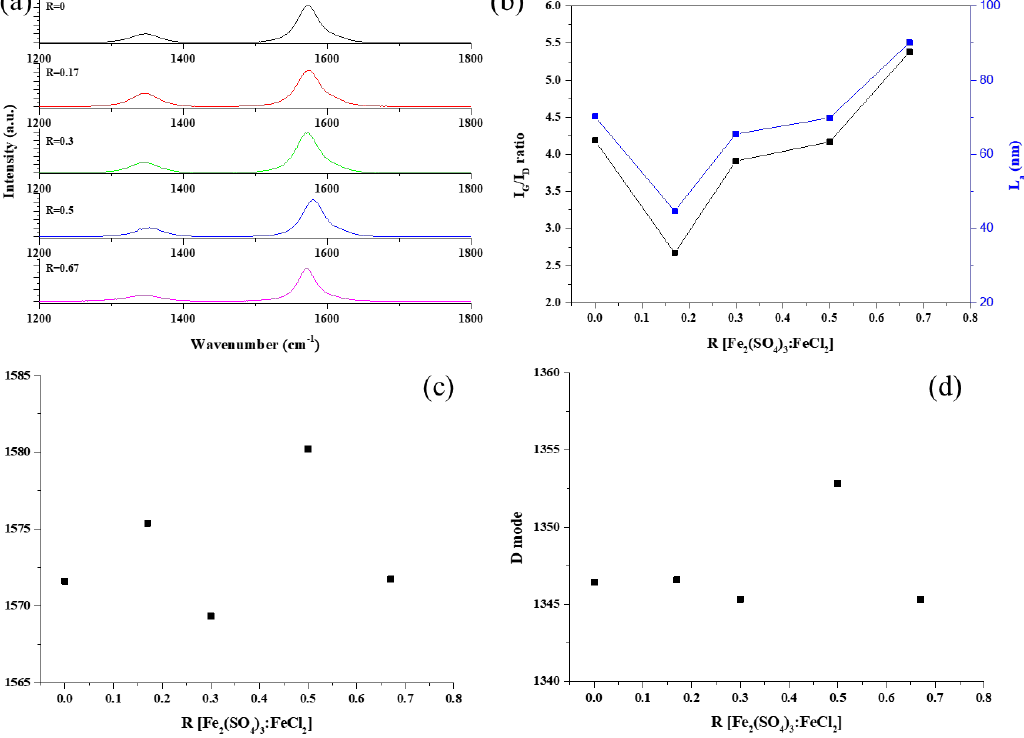
Figure 2. Raman spectra of the CNTs prepared with different R values; ( a ) Raman spectroscopy, ( b ) I G /I D and La values as functions of R, ( c , d ) G-band and D-band peak frequencies as functions of R, respectively.